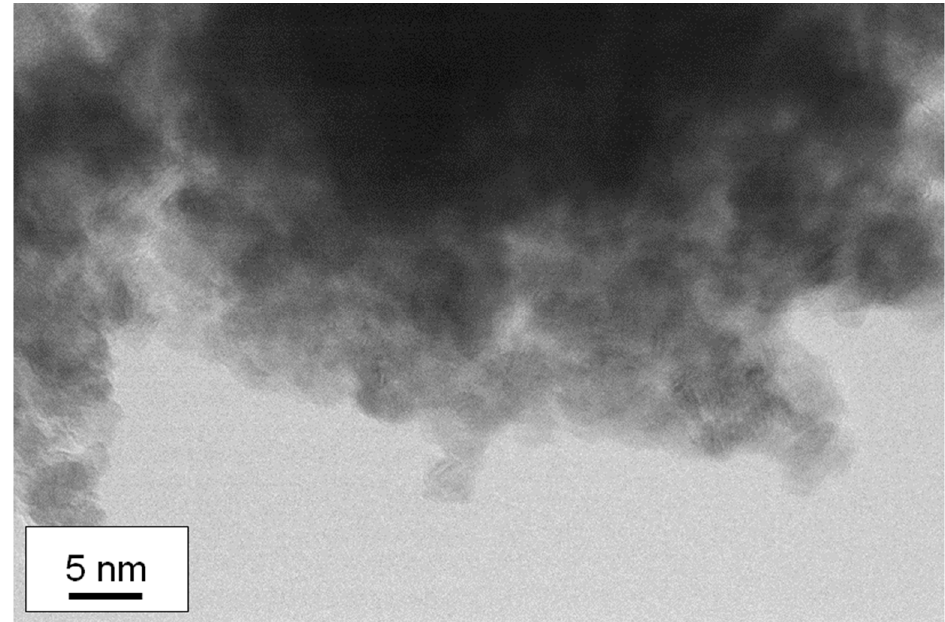
Figure 6. A TEM image of the Sn/Ti oxide sample treated at 500 °C in air (the ratio of Sn/Ti in the precursor solution was 25:75). The period of maximum temperature in the sintering was 30 min.